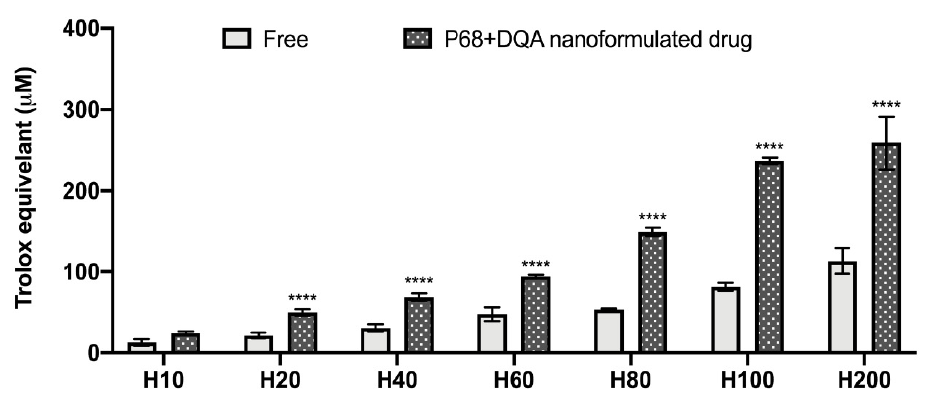
Figure 3. Antioxidant activity of free and P68 + DQA nanoformulated 10–200 µ M HT measured by the FRAP assay (mean ± S.D., n = 6). * represents significance values of nanoformulated drug compared to free drug within the same treatment condition (**** p < 0.0001).